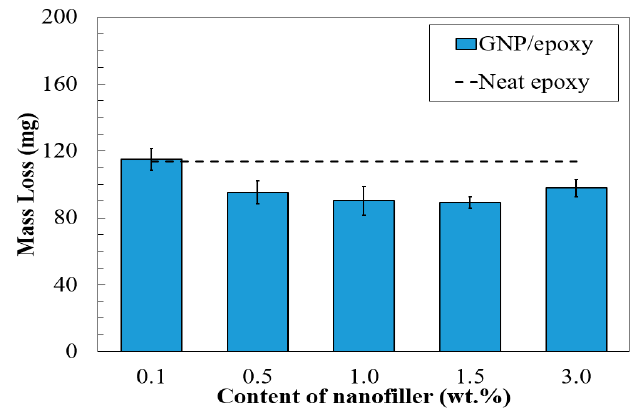
Figure 10. Mass loss of nanofiller/epoxy composites.